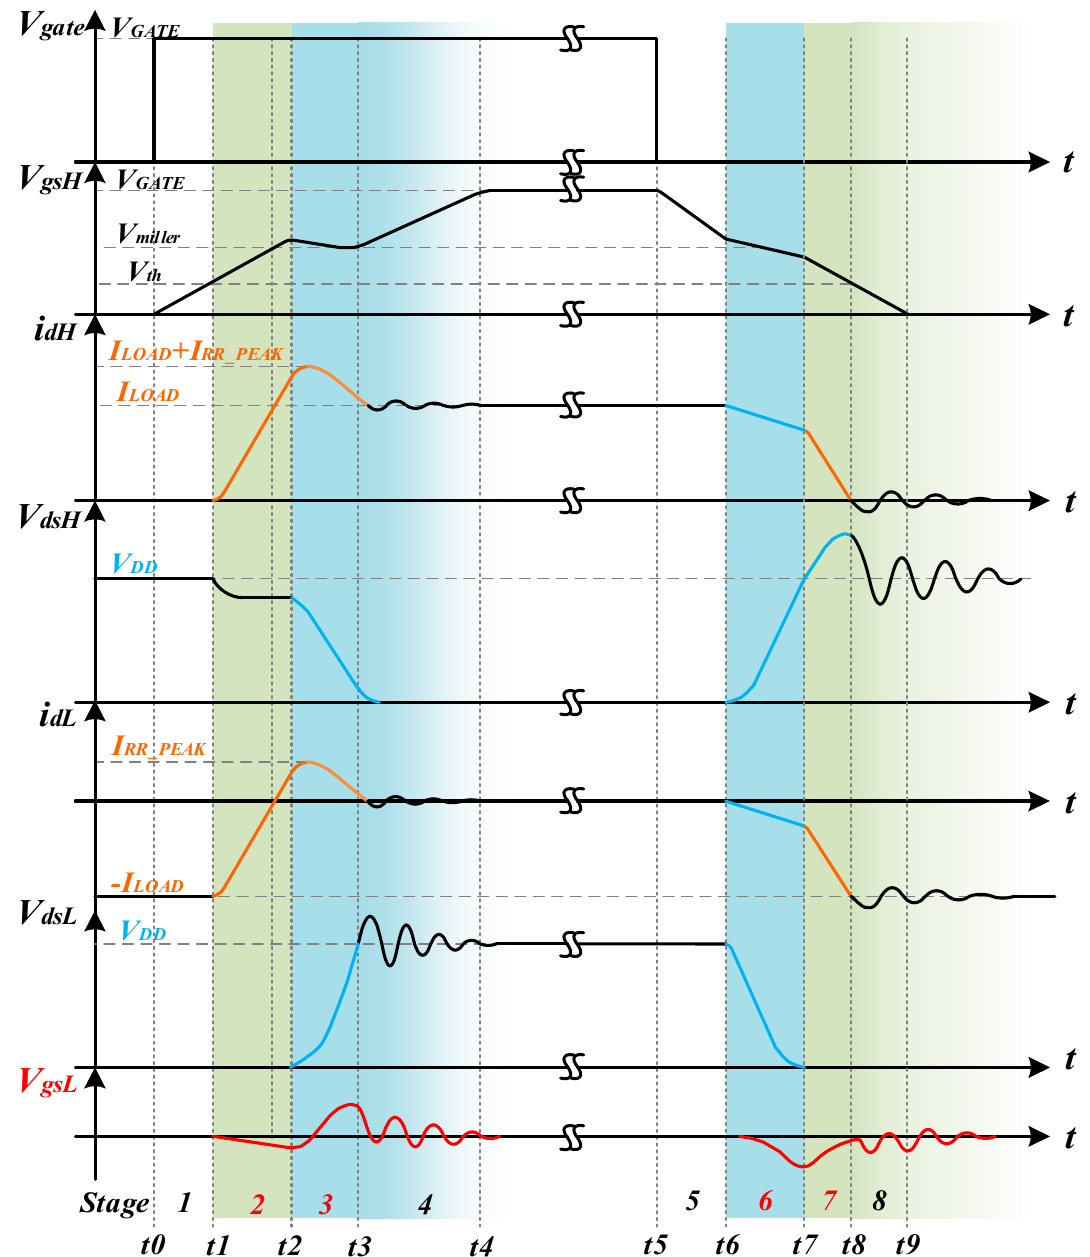
Figure 3. Qualitative analytical switching sequence of turn-on and turn-off stages. The current and voltage switching in the power loop of the bridge-arm cause two key effects that affect the crosstalk. The first one is the rapid current switching generates an induced voltage on the common source parasitic inductance, L sL , which is superimposed in the driver loop. The second one is the voltage switching causes a displacement current of the gate-drain capacitance, C gdL , which forms a circuit through the driver loop. Both of them are directly related factors to the responses of V gsL .